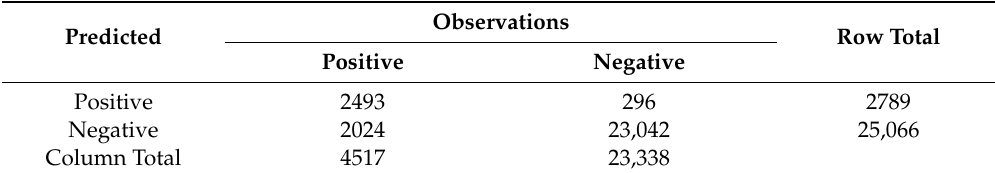
Cross-Tabulation matrix between the flood susceptibility map considering the high